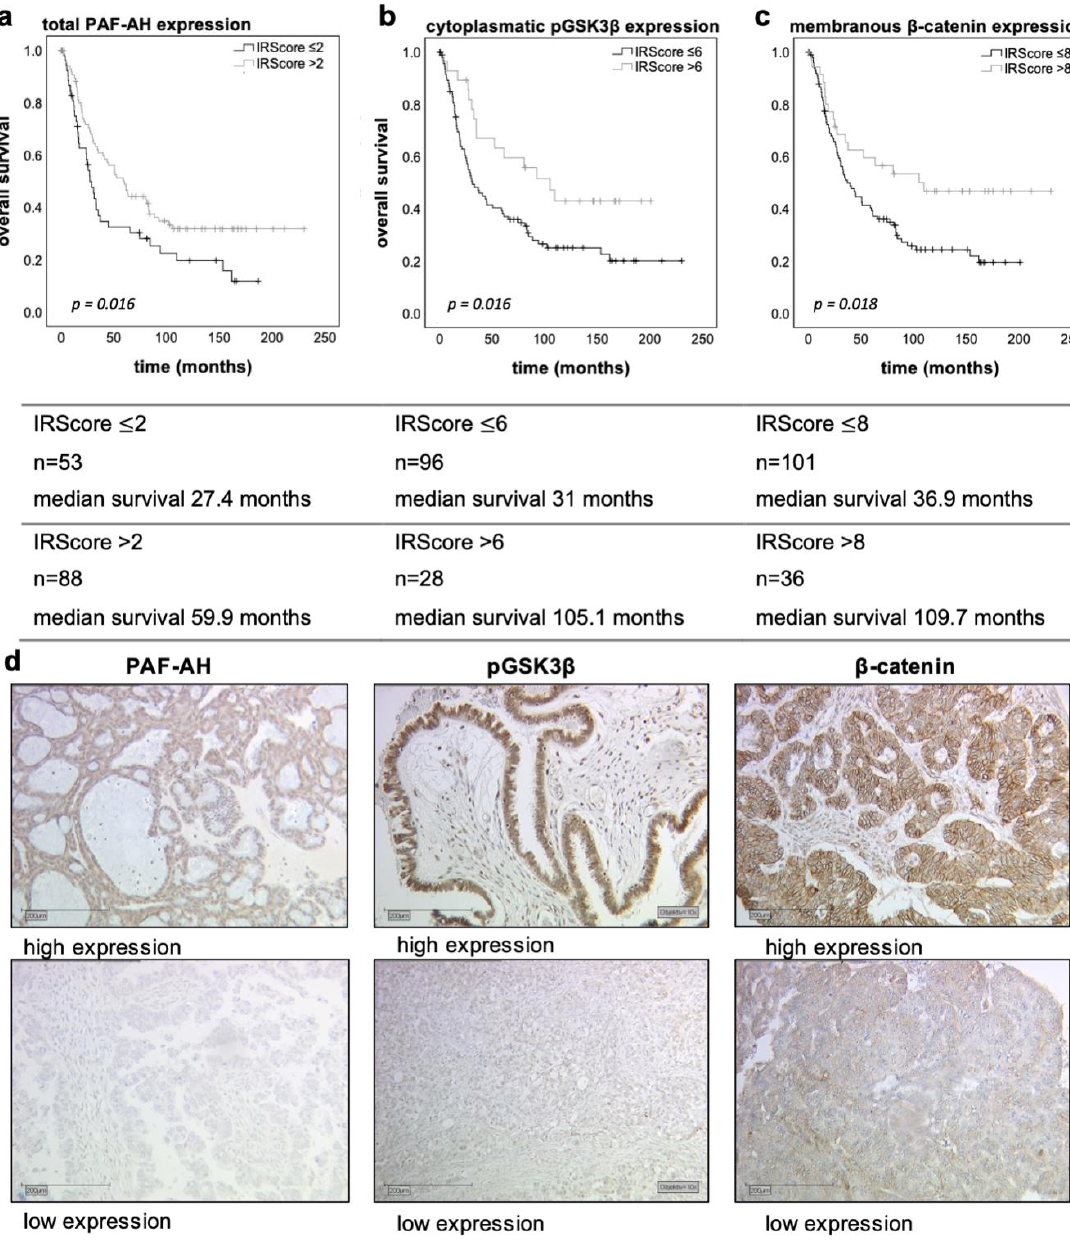
Figure 1. Univariate analyses and representative microphotographs of the immunostainings. The Kaplan–Meier estimates (log-rank testing) show that high tumoral PAF-AH (IRScore > 2; ( a )) expression as well as high levels of cytoplasmatic pGSK3 β (IRScore > 6; ( b )) and membranous β -catenin (IRScore > 8; ( c )) are associated with prolonged OS. Censoring events have been marked in the graphs (+). Representative microphotographs of the immunostainings (10× magnification, scale bar = 200 µm; ( d )) show the difference between high expression (top) and low expression (bottom).